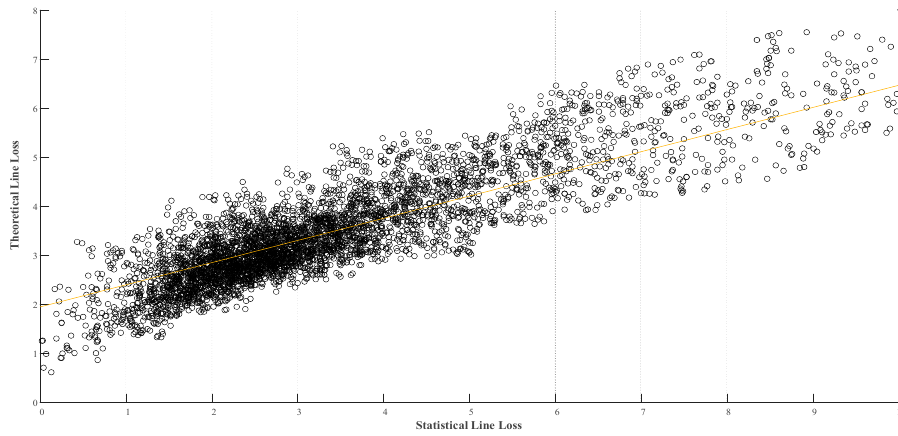
Figure 14. Calculation results based on modified random forest (cleaning rate 46.44%). Table 4. Results of di ff erent methods.